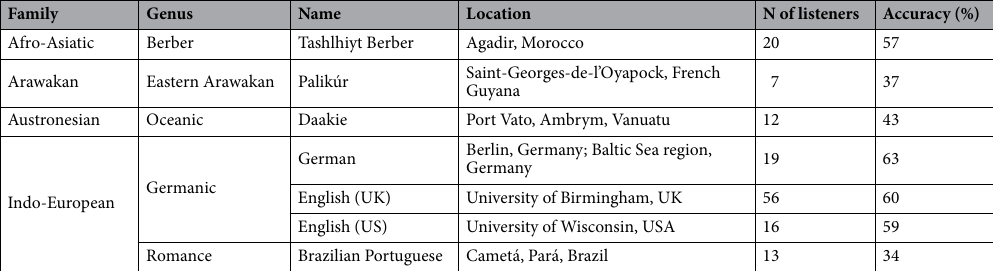
Table 4. Number of listeners and average accuracy (descriptive averages, chance = 8.3%) for each language in the sample for the field experiment; in alphabetical order by language family. Within a language family, the languages are sorted by the accuracy (see Fig. 3 for complementary posterior estimates and 95% credible intervals from the main